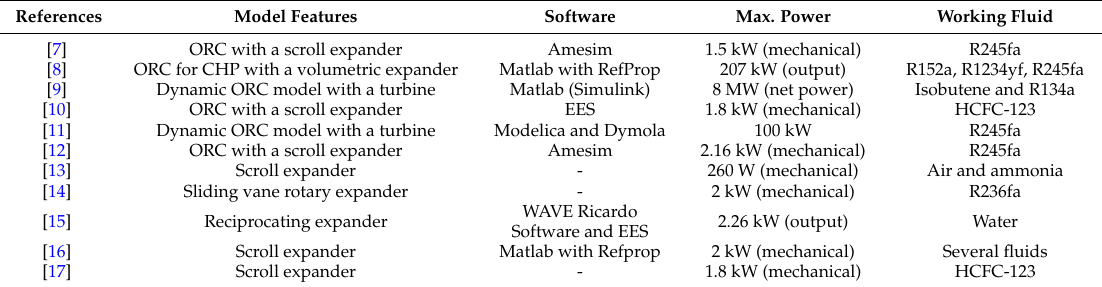
Table 1. Summary of papers about organic Rankine cycles (ORC) modeling. EES: engineerig equation